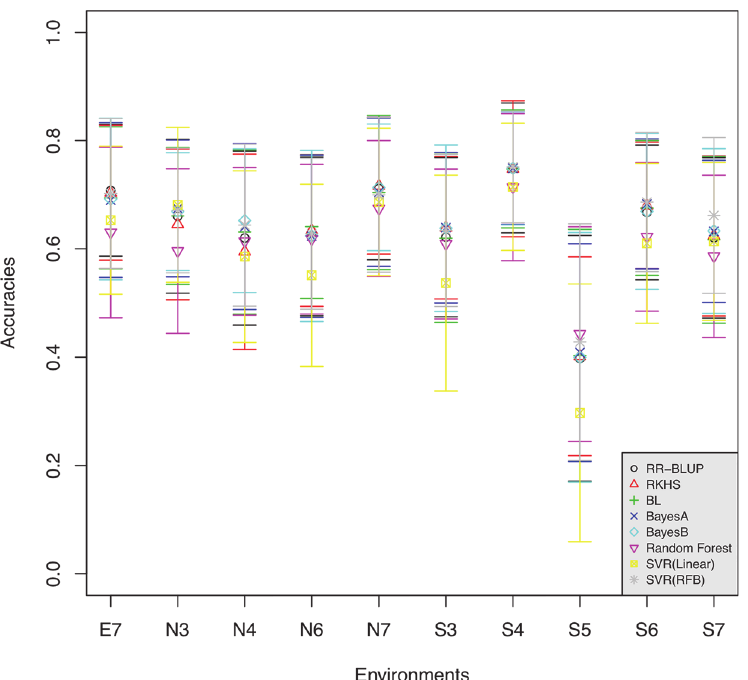
Fig 1. The comparison of the accuracies achieved by eight exiting genome selection models in each of the environment. Each node indicates mean accuracies of 10 runs of 10-fold cross-validation, and the ranges stand for ± standard deviation. The prediction accuracy was calculated as the Pearson correlation coefficient of predicted and observed FT.